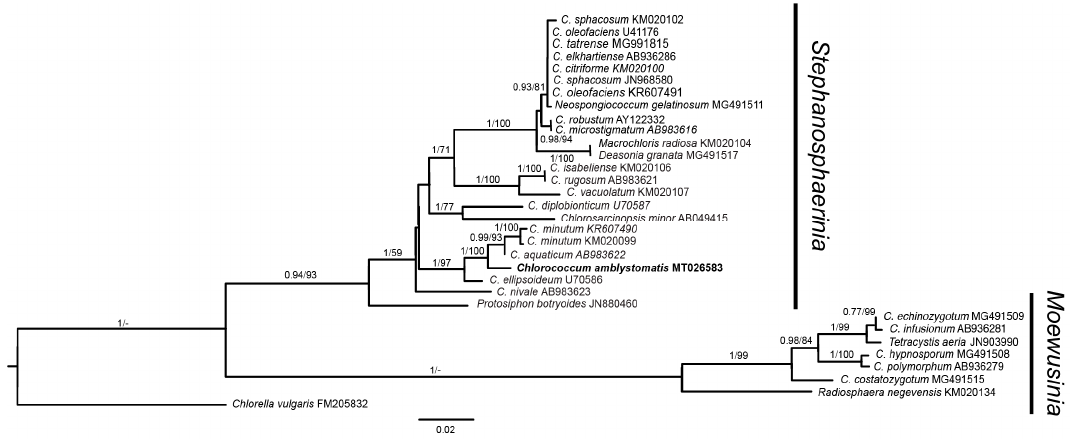
Figure 3. Bayesian inference trees of the family Chlorococcaceae using 18S ribosomal ribonucleic acid (rRNA) sequences show that the novel isolate (acc. number: MT026583) forms a clade sister to C. minutum / C. aquaticum with C. ellipsoideum as an outgroup. Interestingly, the MT026583 sequence is identical to that of Oophila amblystomatis , a species that can be either free-living [33] or a salamander egg symbiont [32]. As these results strongly suggest that O. amblystomatis belongs to the genus